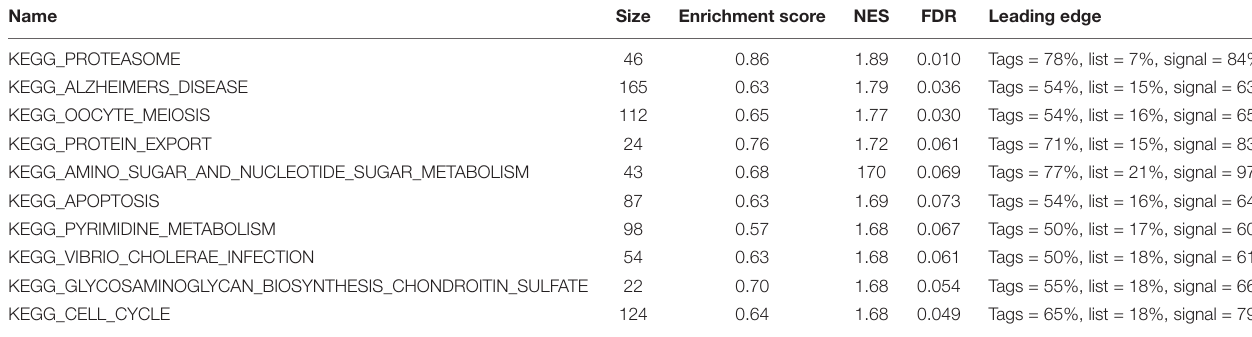
TABLE 3 | Results of the GSEA base on prognostic lncRNA